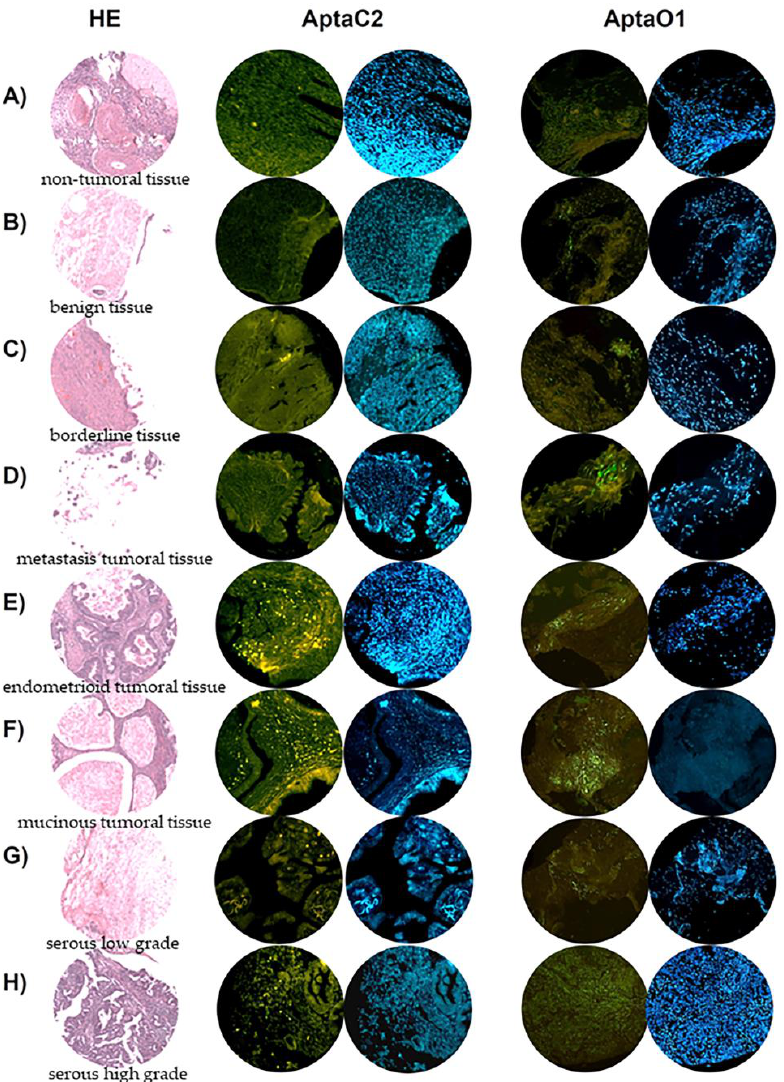
Figure 13. Tissue microarray analysis for the evaluation of AptaC2 and AptaO1 detection capacity for different ovarian tumor samples. Images demonstrate different stages and histologic subtypes of ovarian cancer: ( A ) non-tumoral tissue, ( B ) benign tissue, ( C ) borderline tissue, ( D ) metastasis tumoral tissue, ( E ) subtype endometrioid tumoral tissue, ( F ) subtype mucinous tumoral tissue, ( G ) subtype serous low grade, and ( H ) serous high grade, marked with: HE, AptaO1-FAM, and DAPI.